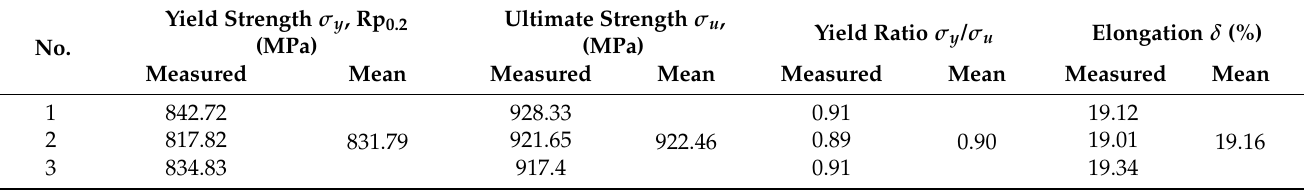
Table 1. Static mechanical properties of the 13Cr110, as extracted from the stress-strain curves (25 ◦ C). Yield Strength σ y , Rp No.